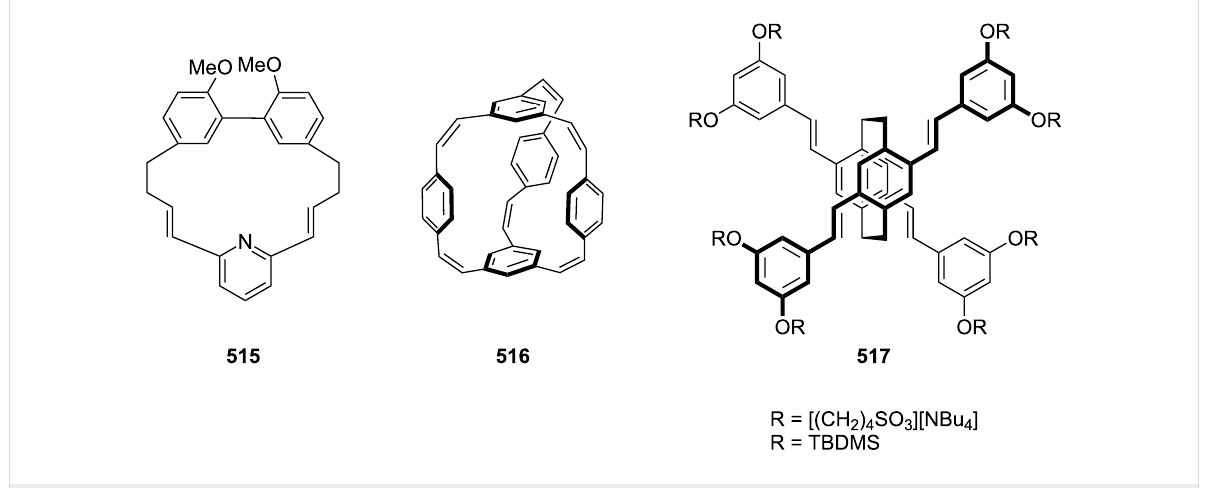
Figure 14: Representative examples of cyclophanes synthesized via Wittig reaction.